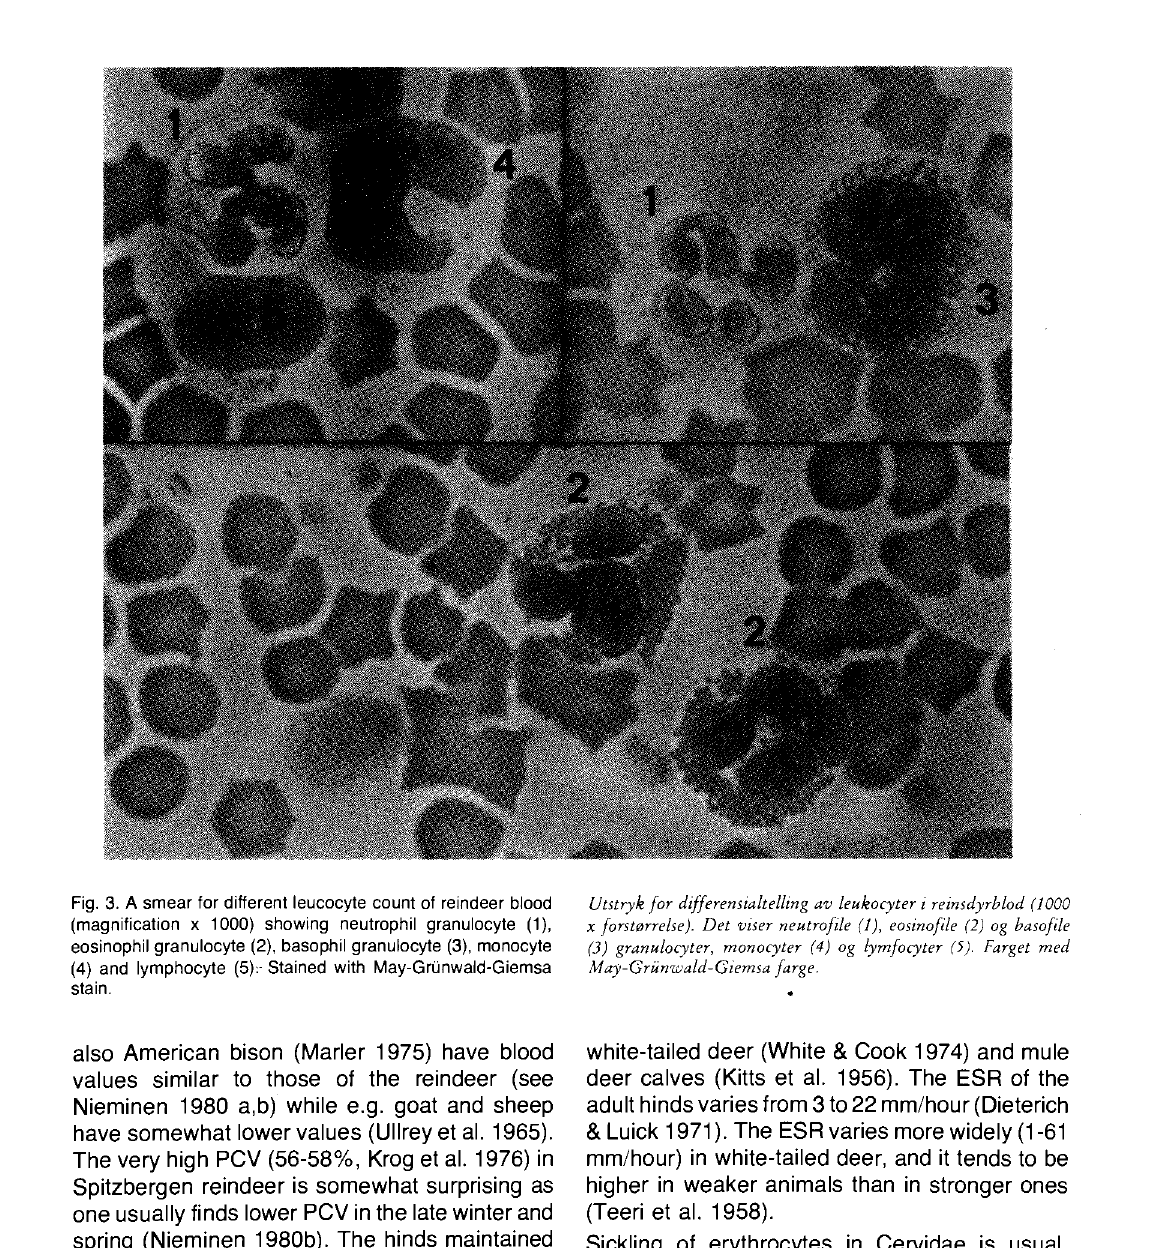
Fig. 3. A smear for different leucocyte count of reindeer blood (magnification x 1000) showing neutrophil granulocyte (1), eosinophil granulocyte (2), basophil granulocyte (3), monocyte (4) and lymphocyte (5): Stained with May-Griinwald-Giemsa stain.